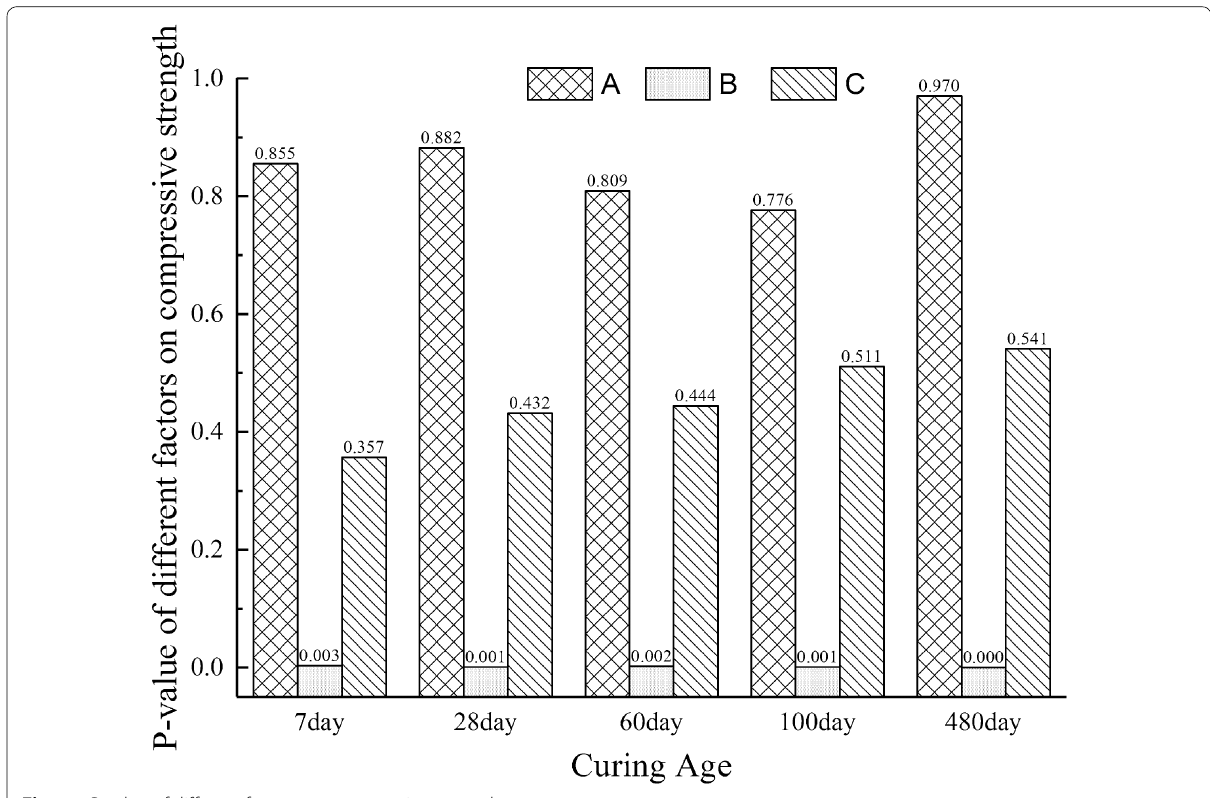
Fig. 15 P-value of different factors on compressive